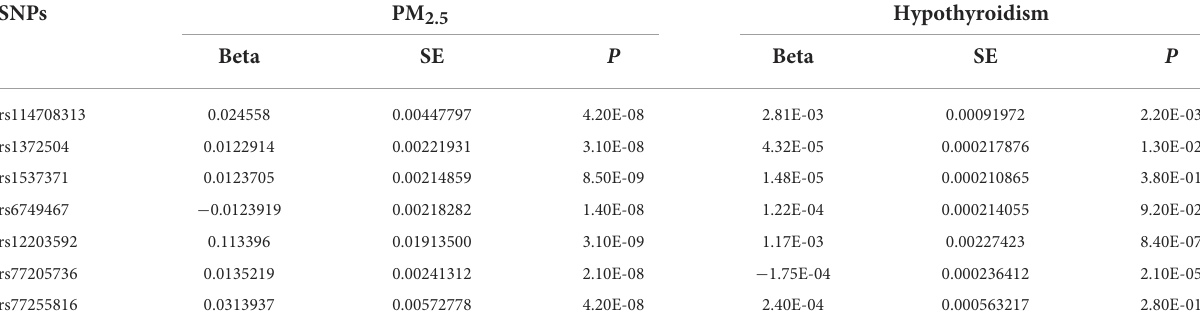
TABLE 1 Correlation of instrumental variables with PM 2.5 and hyperthyroidism.